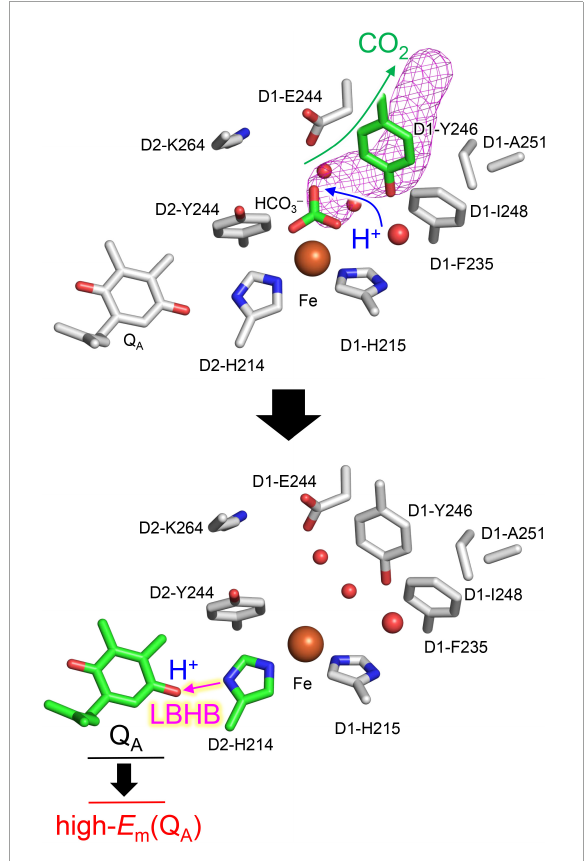
FIGURE8 Overview of the proton-mediated photoprotection mechanism in photosystem